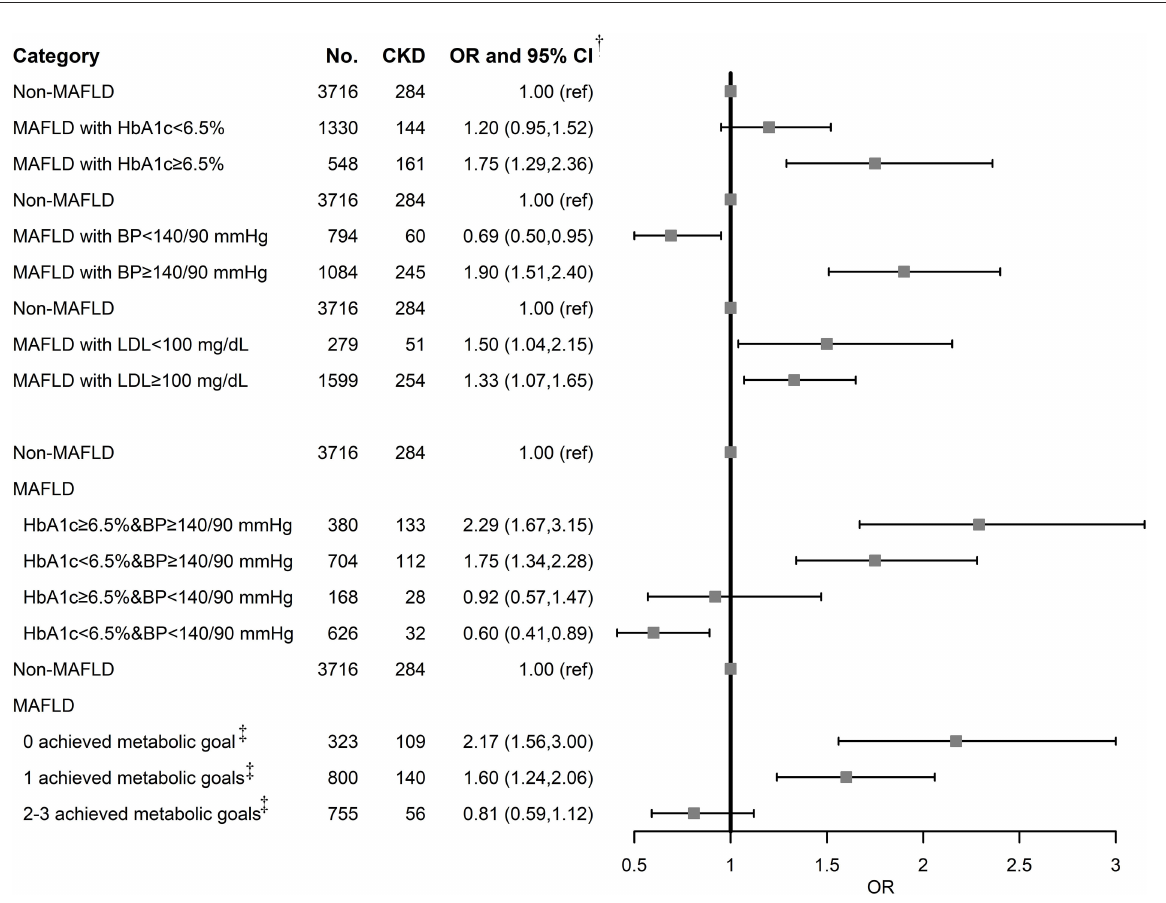
FIGURE2 Association of MAFLD and metabolic goal achievement with CKD. BP, blood pressure; CI, confidence interval; CKD, chronic kidney disease; MAFLD, metabolic associated fatty liver disease; OR, odds ratio; T2DM, type 2 diabetes mellitus. † Adjusted for age, sex, BMI, education level, occupation, alcohol drinking status, tea drinking status, HBV infection, T2DM, and MET/day. ‡ Achieved metabolic goal is defined as HbA1c < 6.5%, SBP/DBP < 140/90 mmHg, and LDL-C < 100